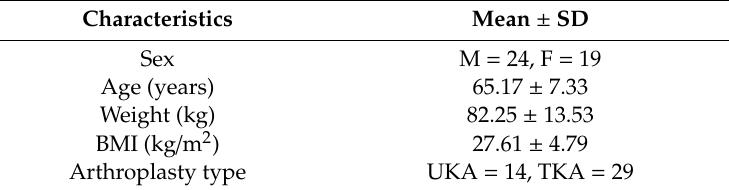
Table 1. Subjects’